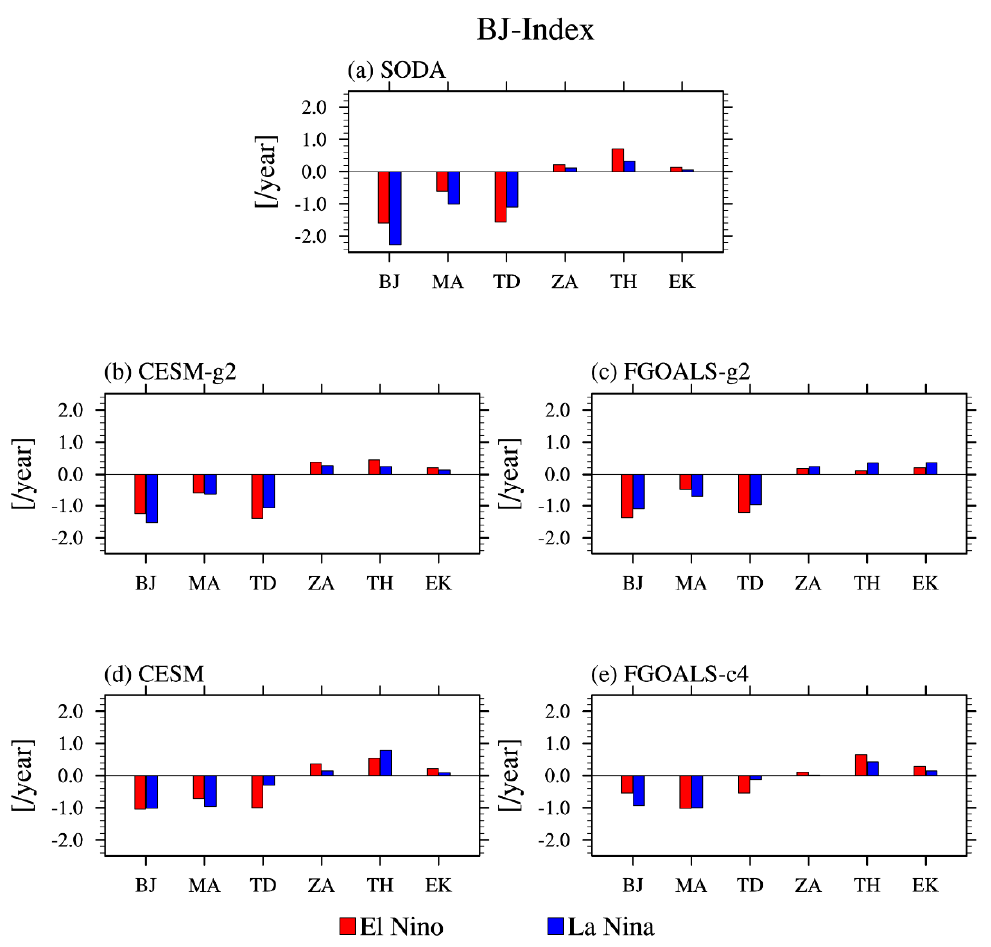
Figure 3. The Bjerknes stability (BJ) index and the five contributed terms in El Niño events and La Niña events for ( a ) the Simple Ocean Data Assimilation (SODA) 2.2.4 (years 1958–1999) and four coupled models: ( b ) CESM-g2, ( c ) FGOALS-g2, ( d ) CESM, ( e ) FGOALS-c4 (years 401–500 in the PI- control runs).